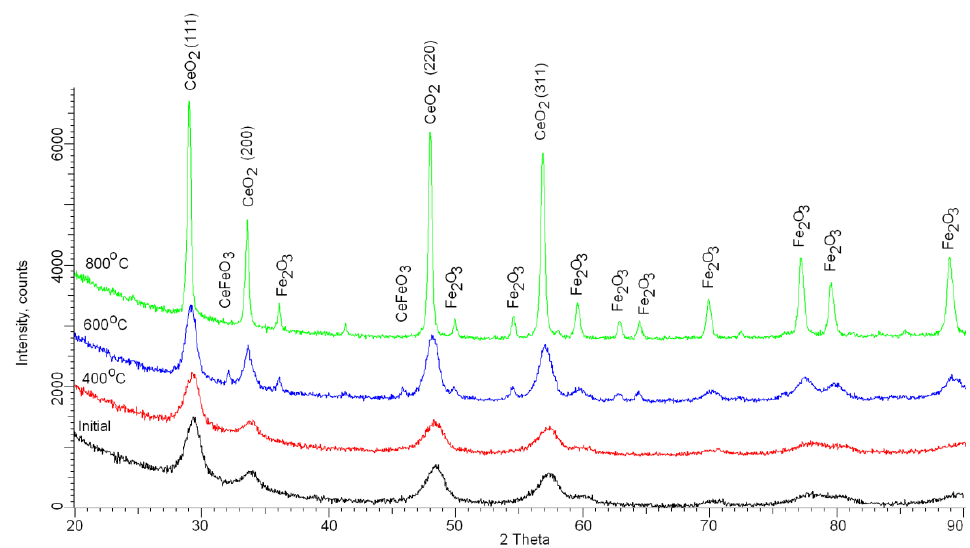
Figure 4. X-ray diffraction (XRD) patterns of the studied nanoparticles before and after annealing. According to the X-ray diffraction patterns obtained, the phase composition of the initial nanoparticles was determined. As is known, in the case of a chemical method for producing nanoparticles based on iron salts, the preferred form of nanoparticle formation is the X-ray amorphous phase of magnetite iron oxide Fe 3 O 4 , which is formed as an outcome of chemical reactions. However, the addition of cerium nitrate to the initial solution leads to the creation of a crystalline phase in the structure. It was established that the structure of initial nanoparticles is characteristic of the cubic phase of cerium oxide CeO 2 , which confirms measurements of the atomic ratio of components in the structure. The low intensity, as well as the broadened and asymmetrical shape of diffraction maxima for the original nanoparticles, is a consequence of the presence of amorphous-like inclusions of iron oxide in the structure. That corresponds to low-intensity and highly asymmetric peaks in the region of 50–70° and a high oxygen share in the structure. A growth in the temperature of annealing gives rise to an increase in intensities and a narrowing of the diffraction maxima. That indicates a drop in contributions of amorphous inclusions and an increase in the degree of structure ordering. Table 2 represents the outcome of the evaluation of the phase composition during heat treatment. Evaluation of alterations in the phase composition in the structure of nanoparticles was conducted using the Rietveld method. The determination of volume fraction of the phase contribution was conducted with the use of formula (1):